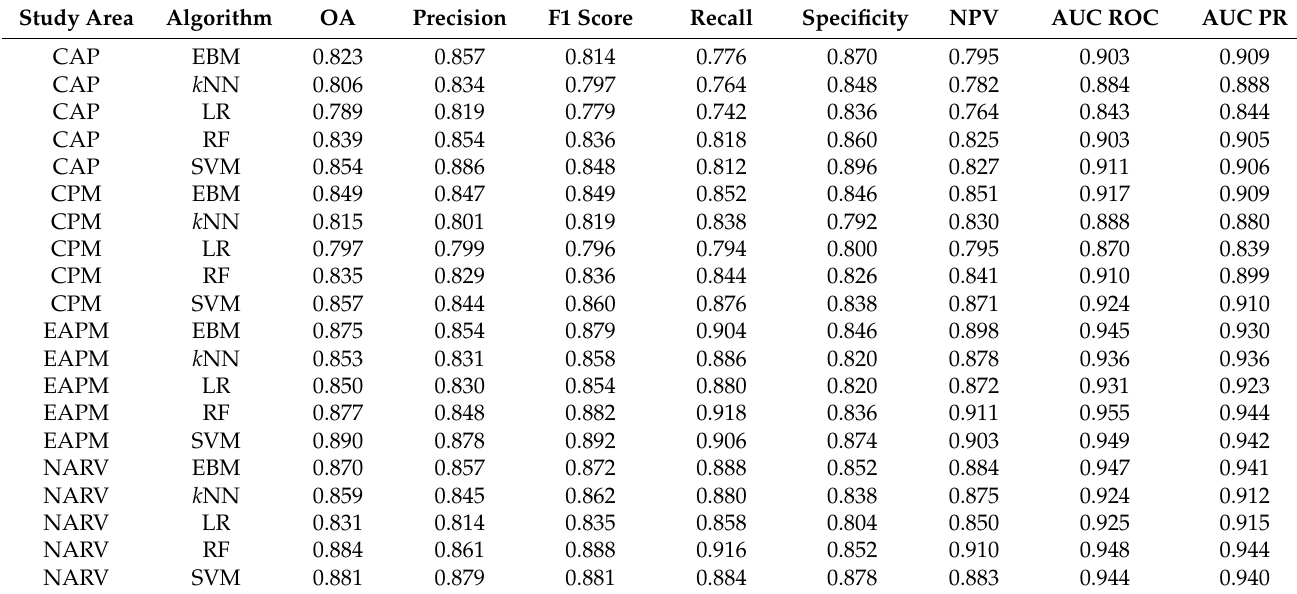
Table 4. Assessment metrics calculated using the withheld validation samples in each MLRA for each algorithm. OA = overall accuracy, NPV = negative predictive value, AUC ROC = area under the receiver operating characteristics curve, and AUC PR = area under the precision-recall